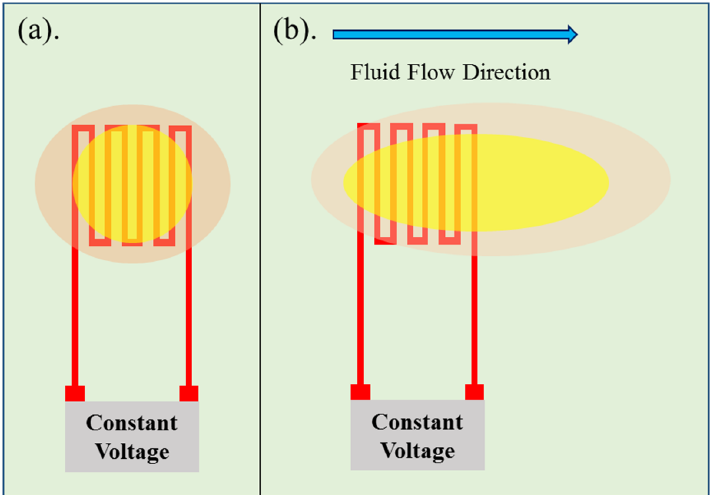
Figure 3. Schematic diagram of hot-wire micro flow sensor principle. ( a ) the flow is zero; ( b ) the flow is not zero.